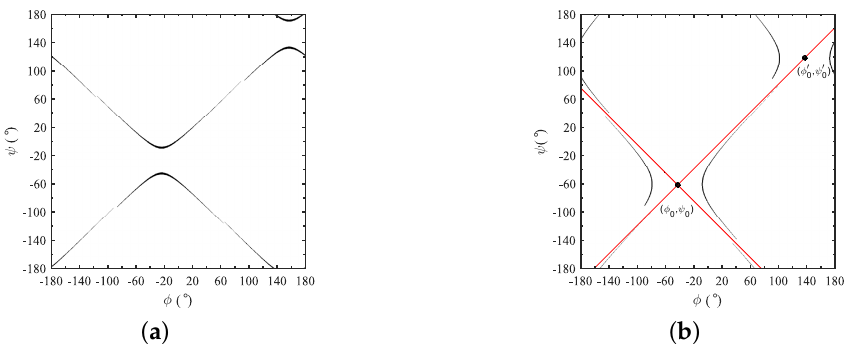
Figure 5. ( a ) Horizontal hyperbola and ( b ) vertical hyperbola representation. The black trace represents those combinations of φ , ψ that yields | J N + 1 | = 1. For illustration purpose all | J N + 1 | values that fit in 1 ± 0.001 have been plotted. The red traces corresponds to the asymptotes. The point ( ψ ) is the origin and ( ψ (cid:48) ) the origin of another hyperbola with a 180 ◦ shift in both , φ (cid:48) 0 , φ 0 0 0